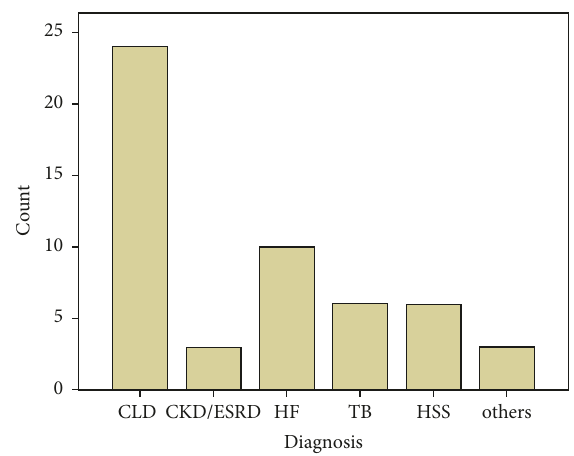
Figure 1: It shows the frequency of the different causes of ascites. CLD: chronic liver disease; CKD/ESRD: chronic kidney disease/ end-stage renal disease; HF: heart failure; TB: tuberculosis; HSS: hepatosplenic